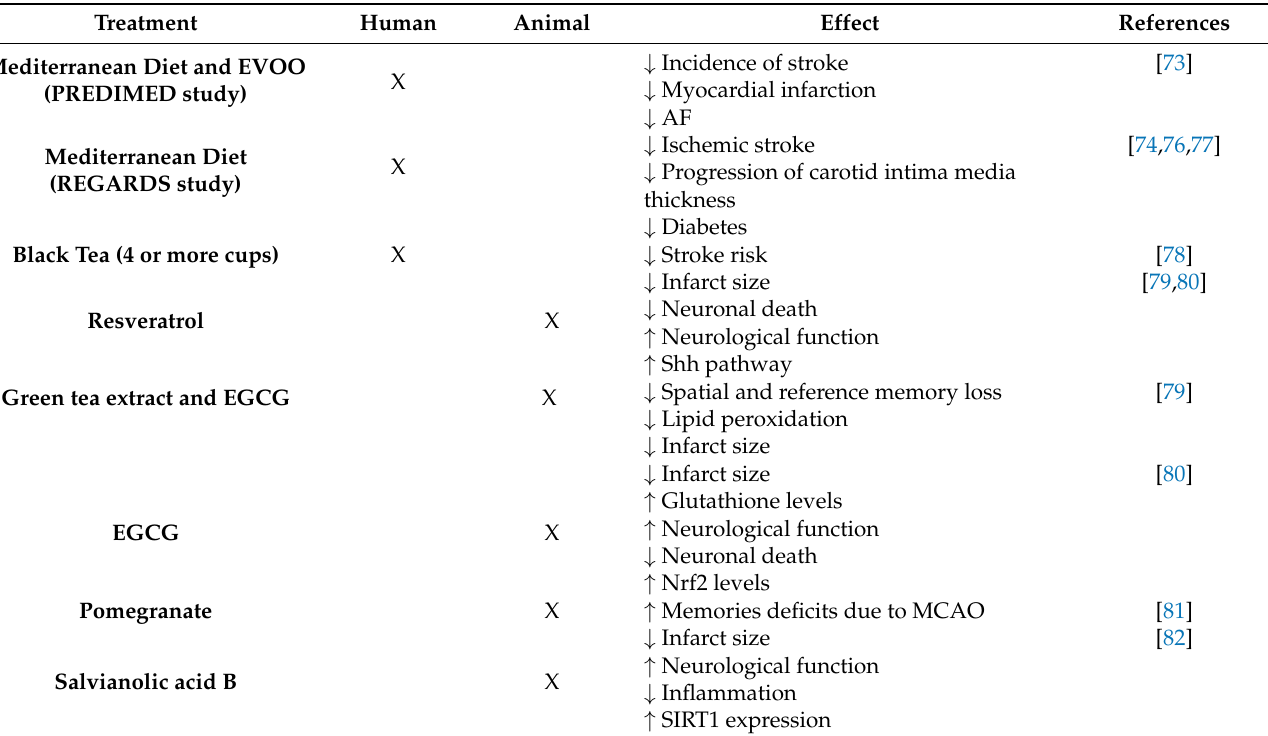
Table 1. Epidemiological Studies showing beneficial effects of polyphenols against Ischemic